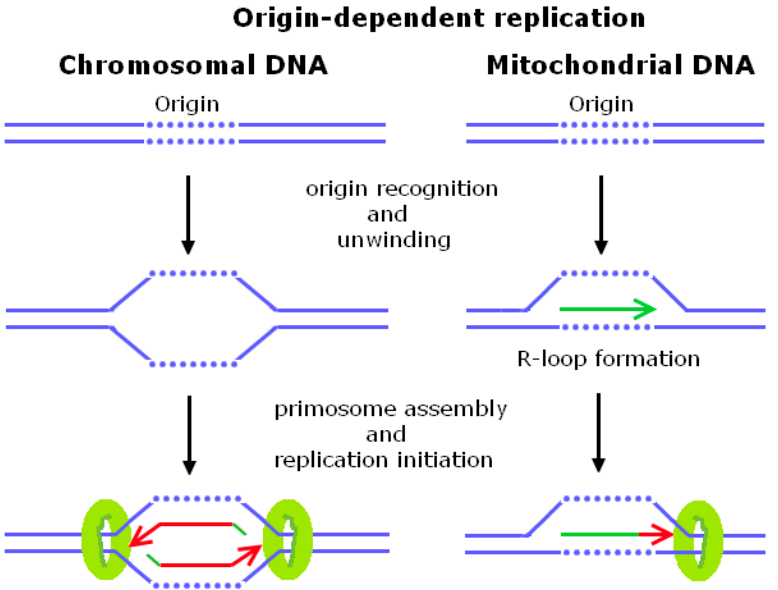
Figure 1. Schematic outline of origin-dependent initiation of chromosomal and mitochondrial DNA replication. cis -acting origin DNA sequences (dotted lines), RNA (green), newly synthesized DNA (red), and helicases (green circle) are indicated. Note that chromosomal origin unwinding is driven by protein–DNA interactions, while transcription-dependent R-loop formation is a key step in mitochondrial origin-unwinding. See text for more details.